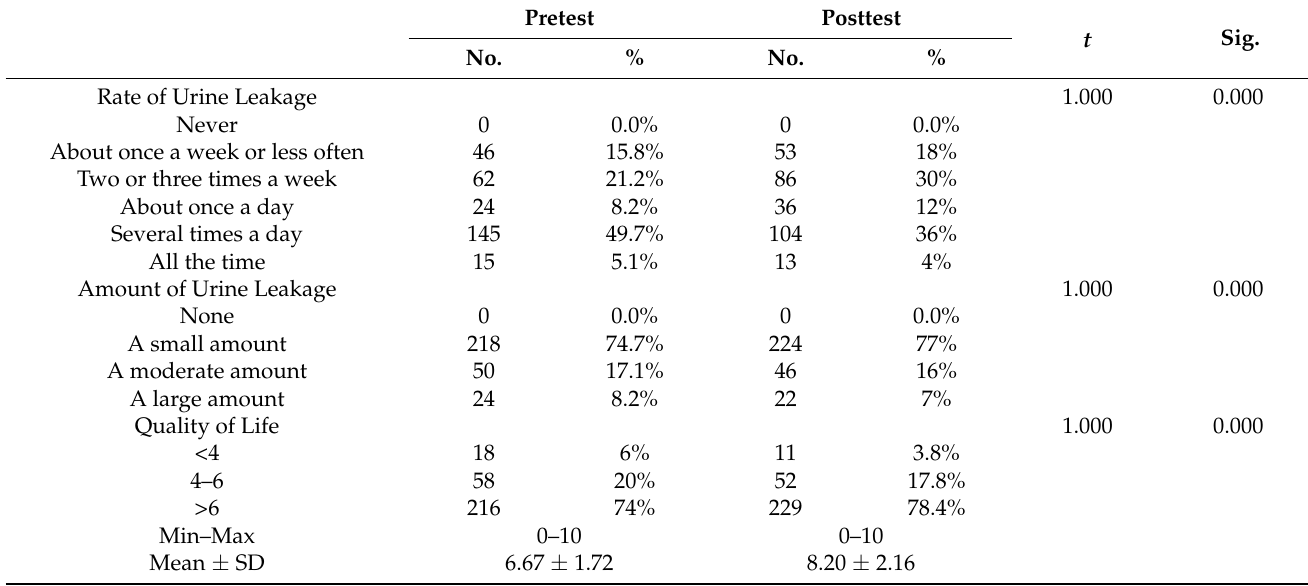
Table 4. Distribution of the subjects according to their pattern of urinary incontinence and quality of life throughout the program